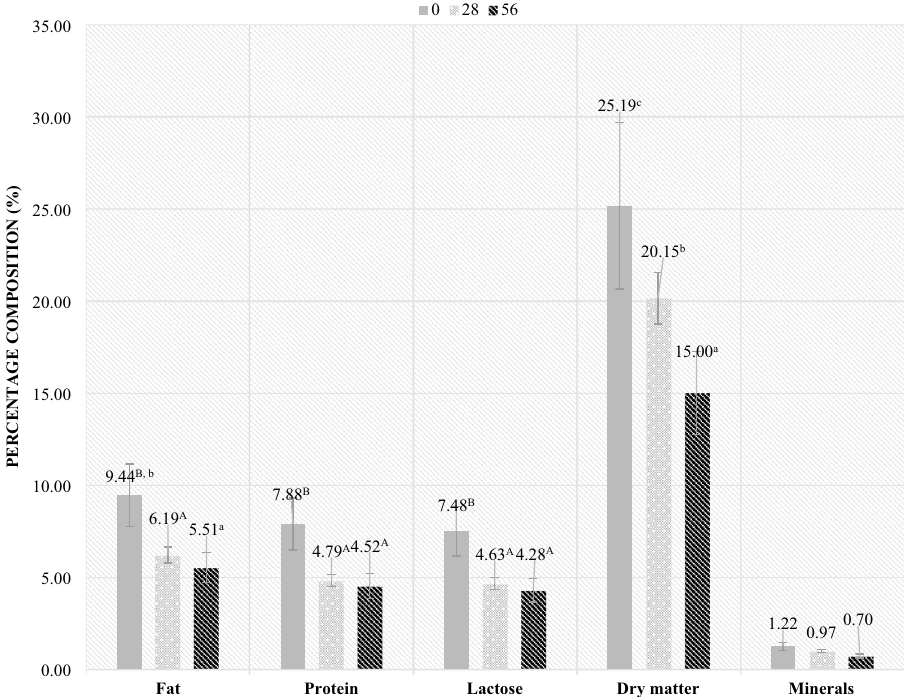
Figure 3. Composition of ewe’s milk depending on the collection day (day 0, day 28, day 56). p < 0.05—A, B, C; p < 0.01—a, b, c.